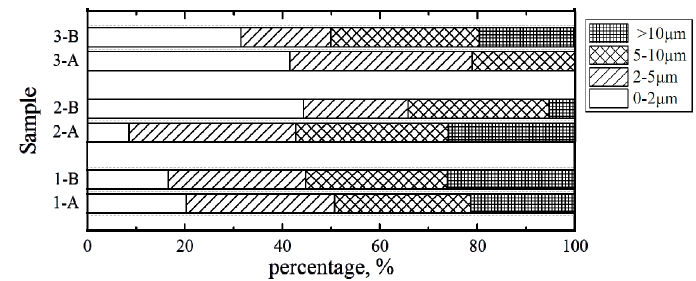
Figure 5. Size distributions of inclusions in all steel samples.